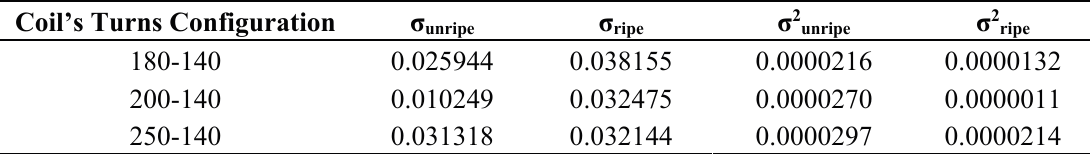
Table 8. Differences between